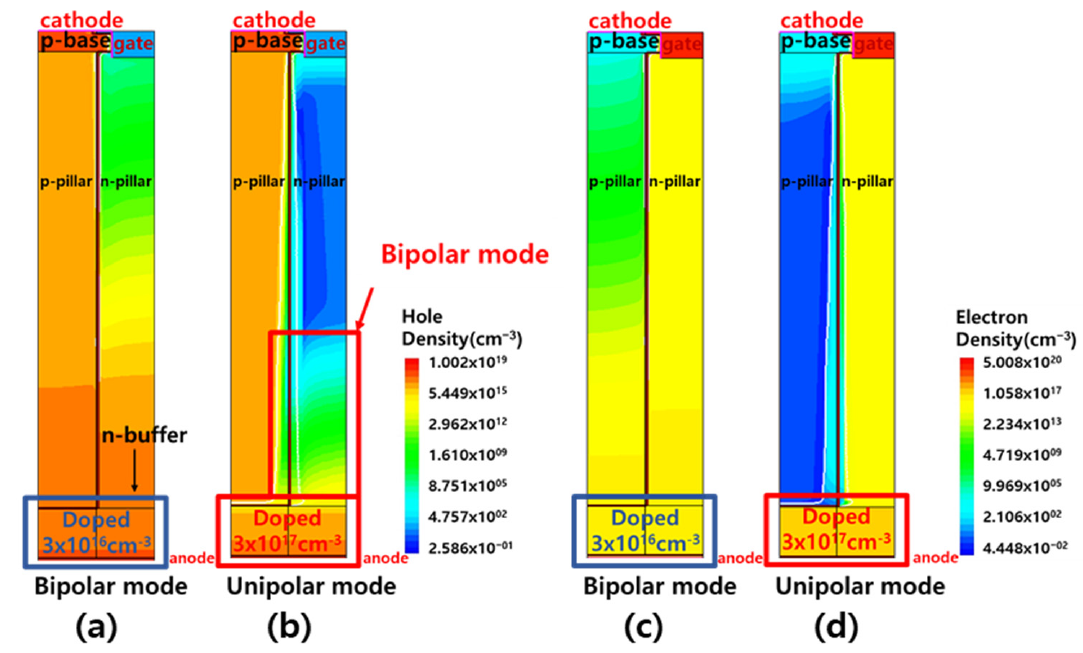
Figure 2. Hole density of ( a ) bipolar mode and ( b ) unipolar mode and electron density of ( c ) bipolar mode and ( d ) unipolar mode. The doping concentrations of the n-buffer layer are 3 × 10 16 cm − 3 and 3 × 10 17 cm − 3 in bipolar and unipolar mode respectively. In Figure 1b, the hole is diffused to the n-drift region and is a minority carrier which reduces turn-off characteristics.